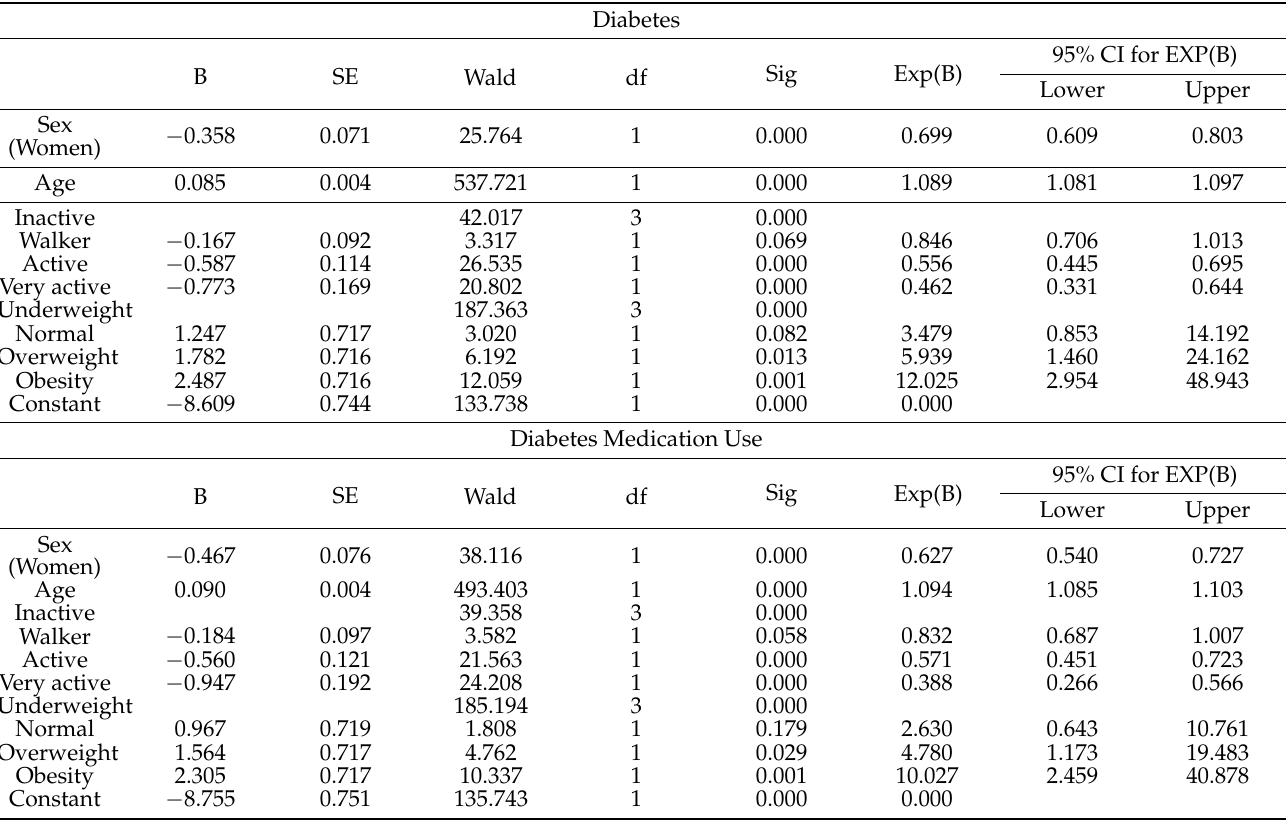
Table 7. Logistic Binary Regression Model for Diabetes and Diabetes Medication Use Risk Factor.